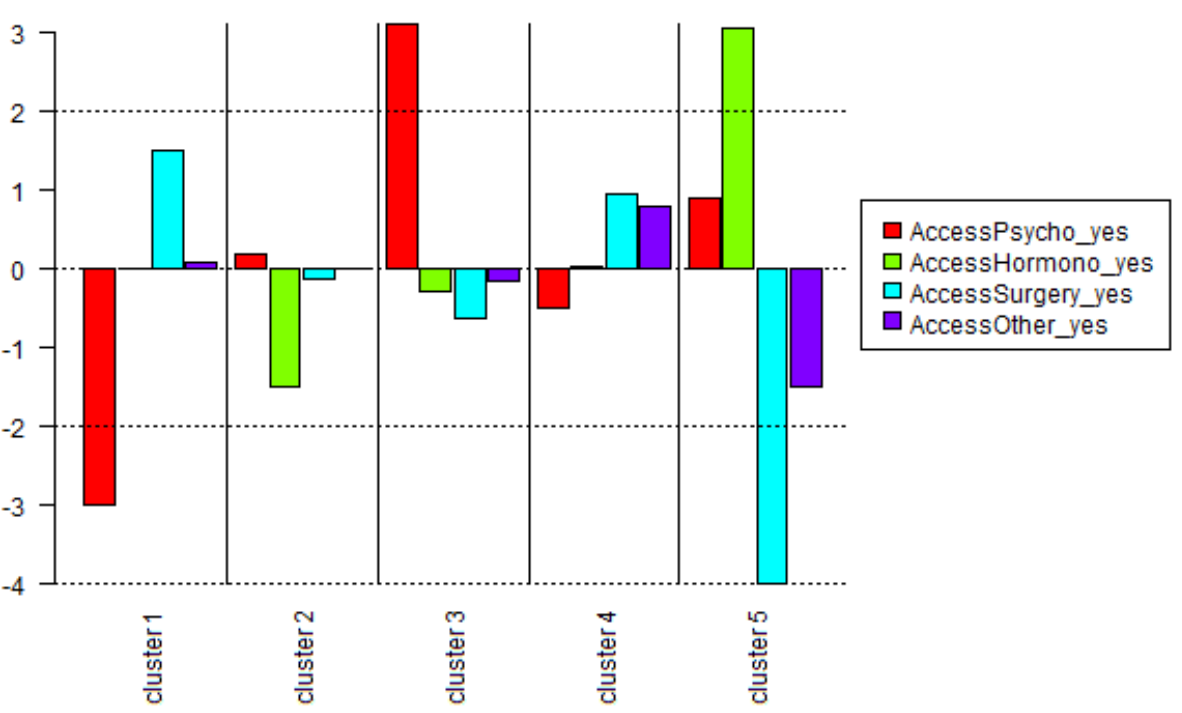
Figure 2. Specificities of descriptive variables describing life-long care between clusters identified by the first Descending Hierarchical Classification. Chi-square presented on ordinate axis; over-representation is represented as positive, under-representation as negative. No correlation is statistically significant. AccessPsycho/AccessHormono/AccessSurgery/AccessOther — Life-long care for psychological support/hormonal treatment/surgery/other (yes; no).